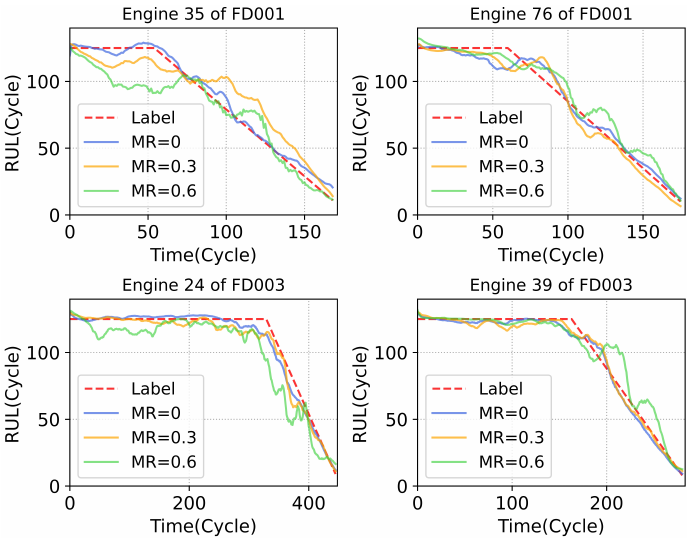
Figure 5. Some typical RUL prediction results of engines in testing set FD001 and FD003 under different missing rates